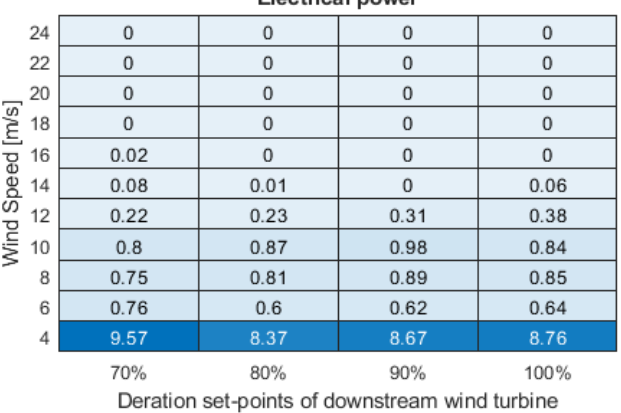
Figure 12. Test error of GPR for electrical power of different deration set-points of downstream wind turbines at I ref = 0.14 with operating upstream wind turbine at 90%. The model was trained and tested in an input data set that does not contain input data of I ref = 0.12,0.14,0.16 and downstream wind turbines at 70%, 80%, 90% and